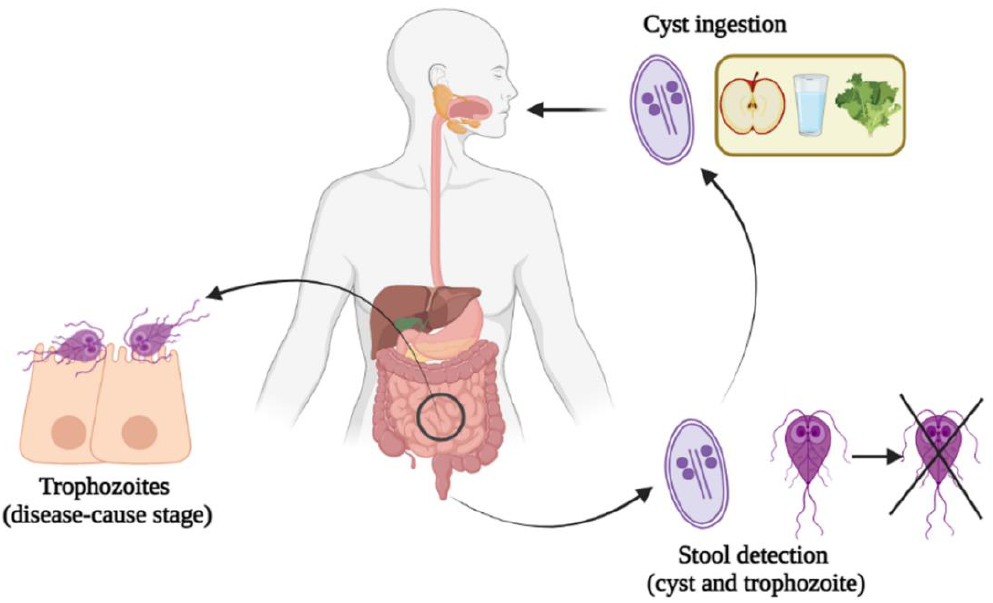
Figure 1. Lifecycle of Giardia lamblia . Infectious cysts are ingested via contaminated food or water, or by direct ingestion. In the human gastrointestinal tract, cysts excyst to release trophozoites, which cause disease, in part, by promoting the disruption of the intestinal epithelial barrier. Both the cysts and trophozoites can be detected in the stool, although the trophozoites released do not survive long.